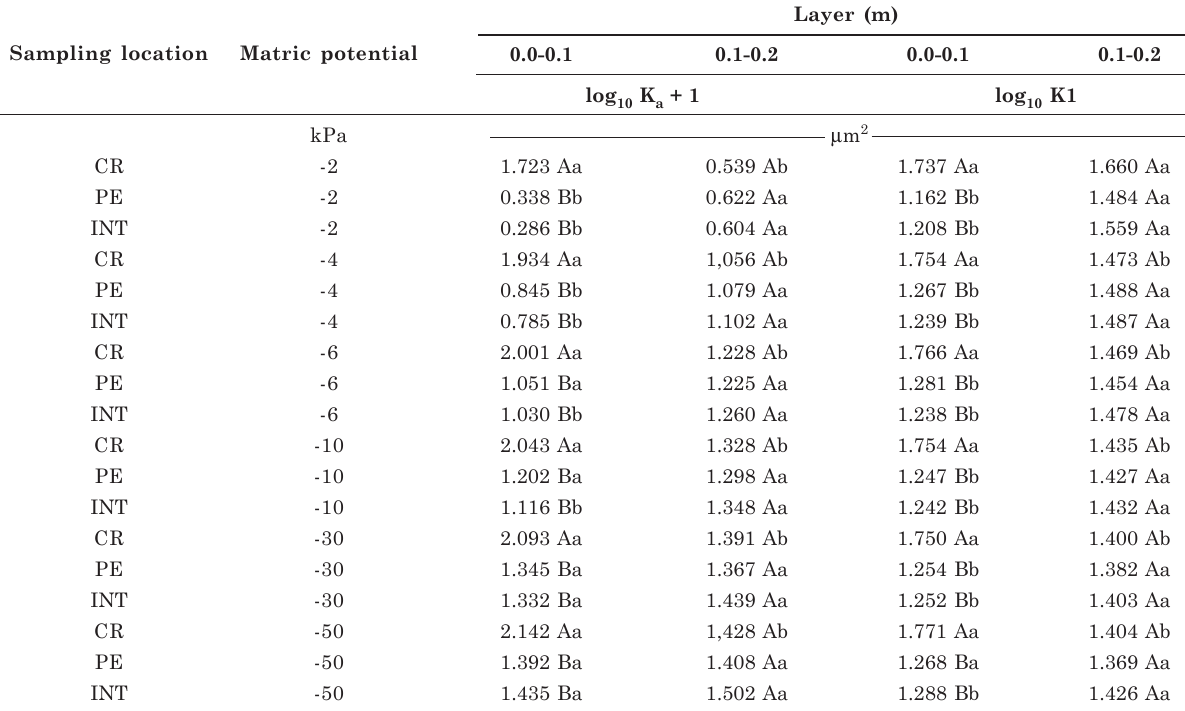
Table 2. Soil air permeability (K a ) and index of pore continuity (K1) at the sampling locations crop row (CR), interrow (INT) and the point equidistant between these CR and INT (PE), in two soil layers (0.0-0.1